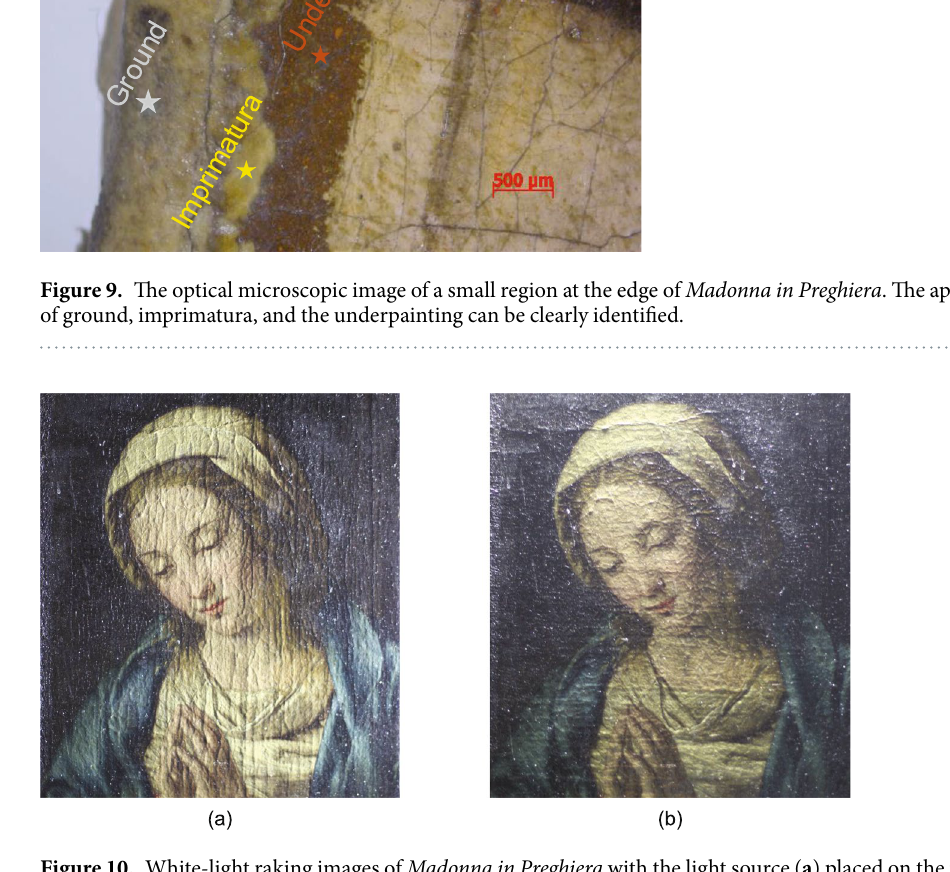
imprimatura, literally the ‘first paint layer,’ follows the ground that would seal the oil-absorbent layer. Without the imprimatura, paint directly applied would soak into the ground and be difficult to control. The underpainting layer provides a proper foundation of the scene/subject matter, which was typically painted in a dark and muted monochrome tone, usually consisting of umber, as brown underpainting has often be used in oil painting from the 15th to 17th centuries. Such an approach was widespread to the point that the entire tonality and compo- sitions of paintings frequently accounted for this dark underpainting. THz B- and C-scans clearly reveal the features of the ground, imprimatura, and the underpainting layers, which are fairly uniform across the paint- ing. Assuming the refractive index of gesso is about 1.52 10 , the average physical thickness of the ground layer is about 132.7 μ m. For other oil-based paint layers, although the difference of refractive index between each layer is sufficient to produce the THz reflections, we assume a mean refractive index of 1.85 10 in order to estimate the physical thickness of each paint layer. Based on this assumed refractive index, we estimate the average thickness of imprimatura is ~34 μ m and the average thickness of the underpainting layer is ~38 μ m. The presence of these three preparatory layers is confirmed by optical microscopy near the painting’s edge, shown in Fig. 9, where these layers are exposed. The pictorial layers are applied subsequent to the underpainting. They contain the visually evident com- position of the finished painting, and consist of additional applications of background color, the figure of the Madonna , facial features, hands, the gossamer veil, and other fine details. In the THz C-scans, textural features due to the craquelure first become pronounced in the pictorial layer. This is also where we observe the presence of delamination, closely associated with the craquelure. The surface morphology due to the craquelure can also be seen in white-light raking images shown in Fig. 10. In Fig. 10(a), the raking light source was placed to the right of the painting, emphasizing inhomogeneities oriented in the vertical direction; in Fig. 10(b), the raking light source was placed toward the top side of the painting, emphasizing inhomogeneities oriented in the horizontal direction. Again, there is strong correlation of the features seen in the raking-light images and in the THz C-scans in Fig. 7.